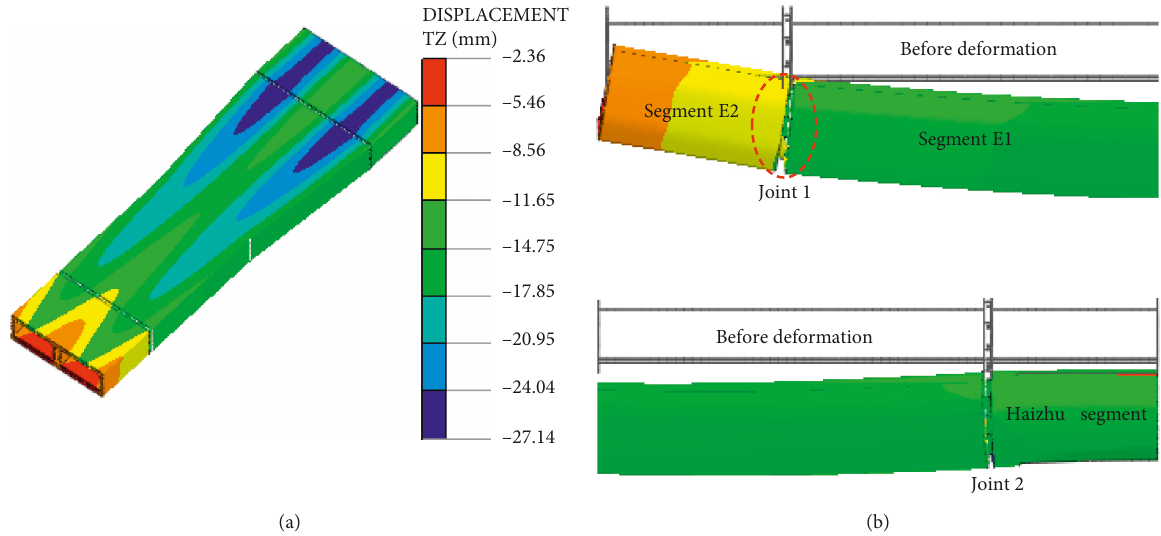
Figure 12: The vertical displacement and deformation under working condition 7: (a) settlement nephogram; (b) spatial deformation at a × 2